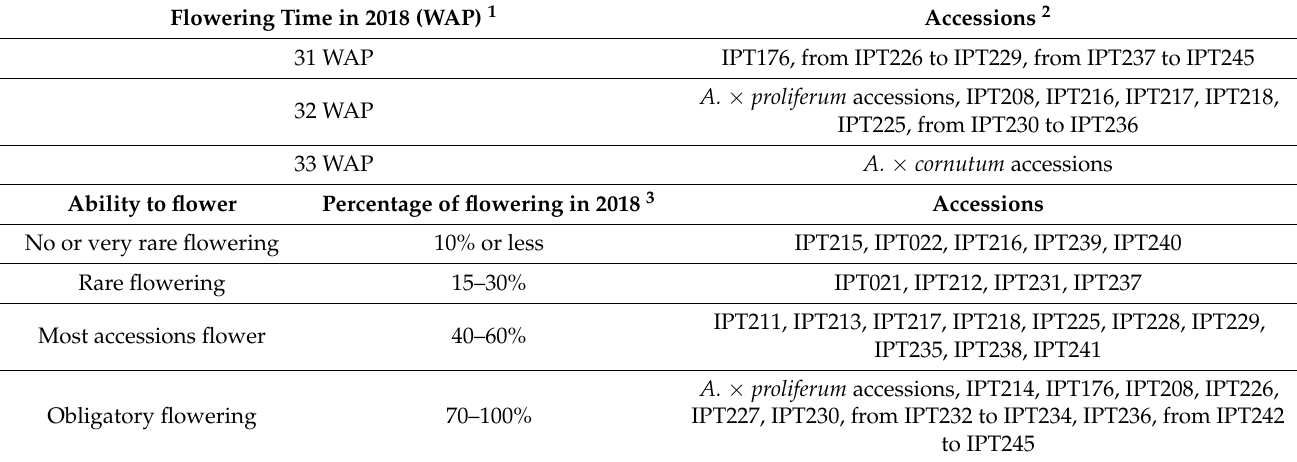
Table 1. Flowering time and ability to flower of Croatian shallot accessions.